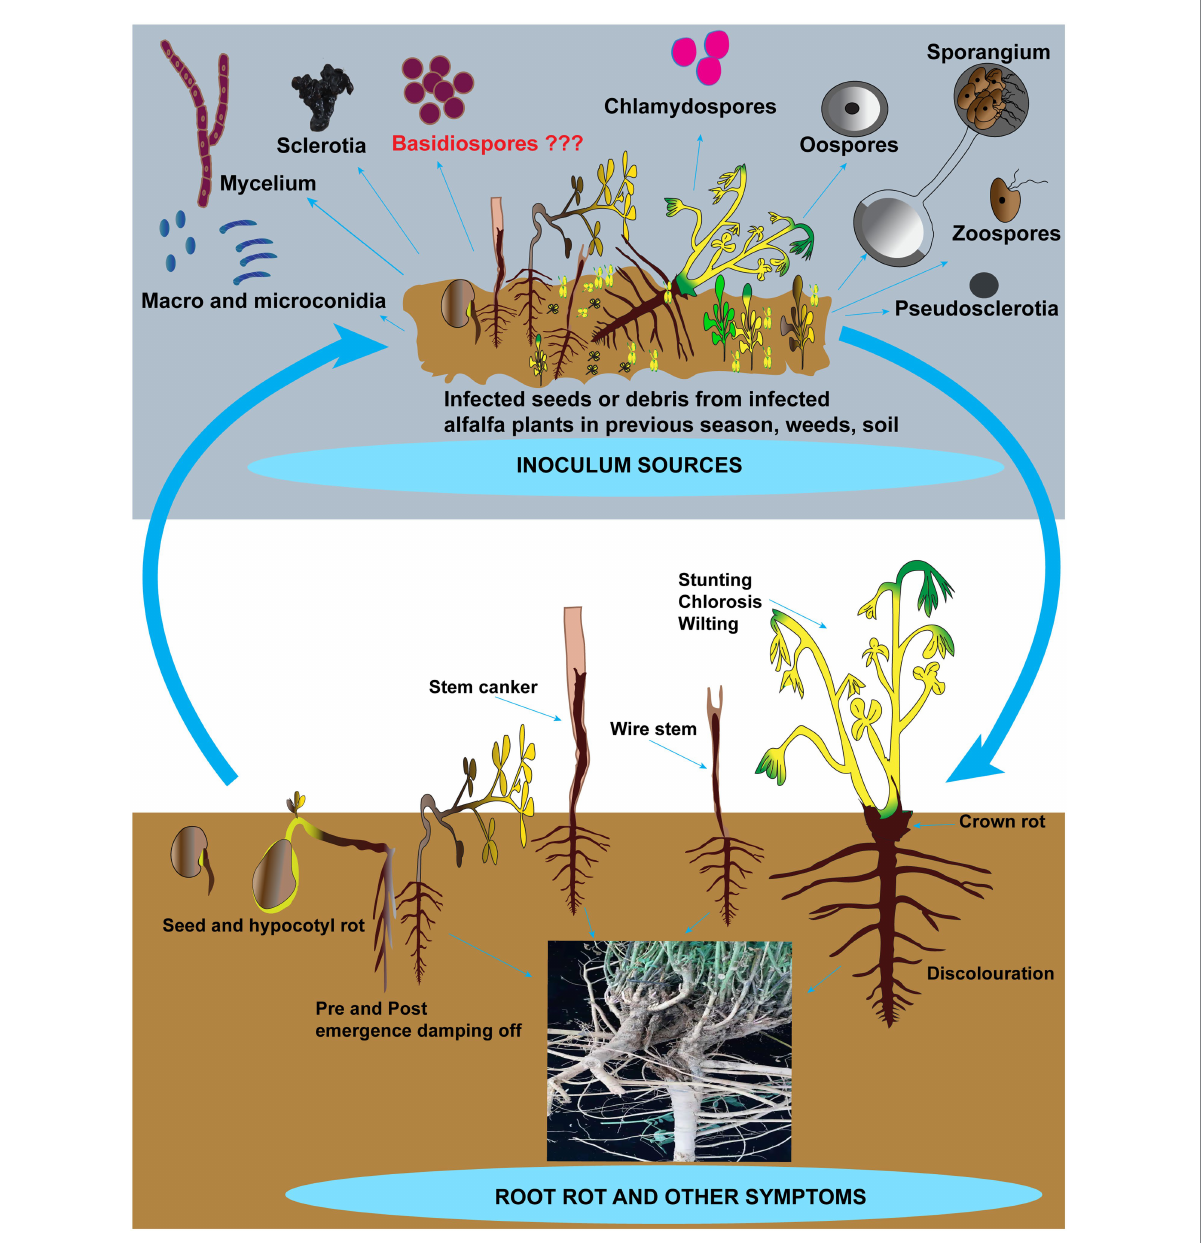
FIGURE 2 Schematic representation of alfalfa root rot and other symptoms and inoculum sources. Inoculum sources include zoospores, oospores, sporangia, conidia, chlamydospores, sclerotia, mycelia, and basidiospores (not reported). Besides root rot, other symptoms include damping-off, seed and hypocotyl rots, discoloration on roots, crown rot, stunting, chlorosis, wilting, and wire